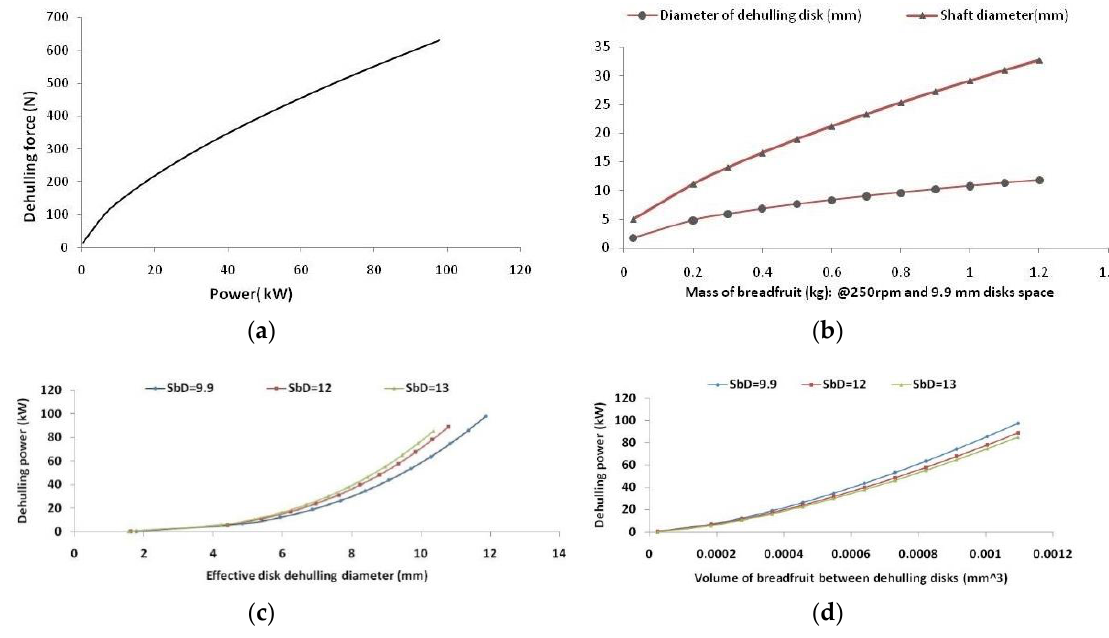
Figure 3. Engine design parameters correlation at 250 rpm. ( a ) Dehulling force and prime mover power; ( b ) Effective disk dehulling diameter, required shaft (feeder) diameter and machine feed capacity mass; ( c ) Relationship between required dehulling power and effective disk dehulling diameter for different space between disks (SbD); ( d ) Relationship between required dehulling power and volume of breadfruit between dehulling disks for different spaces between disks (SbD).